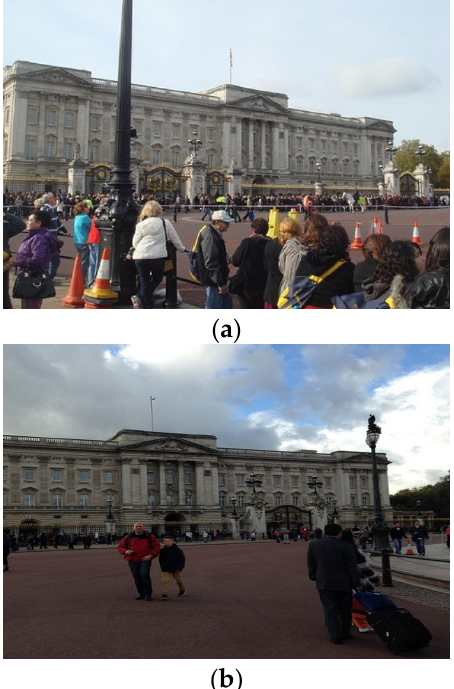
Figure 4. The image pair with low similarity. ( a , b ) are pictures of a landmark location, but the camera angle and image content are very different.